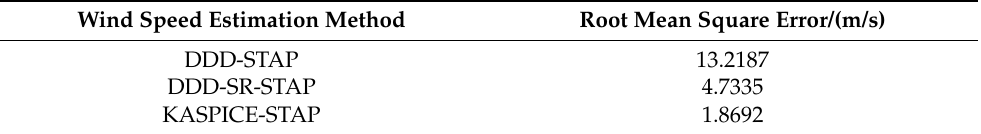
Table 2. Comparison of root mean square error of low-altitude windshear wind speed estimation. Wind Speed Estimation